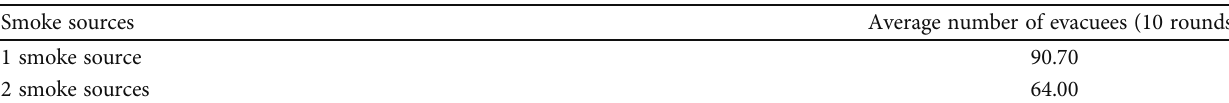
Table 4: Average number of evacuees of ten trial runs of 100 individuals with 3% guiders in simulations. There are one and two smoke sources. For a source of smoke, it is located in the middle of the room. Two sources of smoke are placed in the middle of the room and in front of exit 1. The simulation domain is a room with two exits as Figure 3(b). The entire time period of a simulation is 50s.